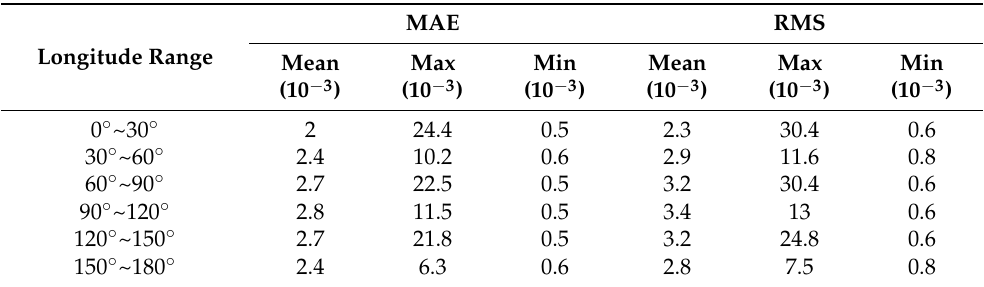
Table 5. Statistical results: MAE and RMS for the G Π model across different longitude ranges in 2014.